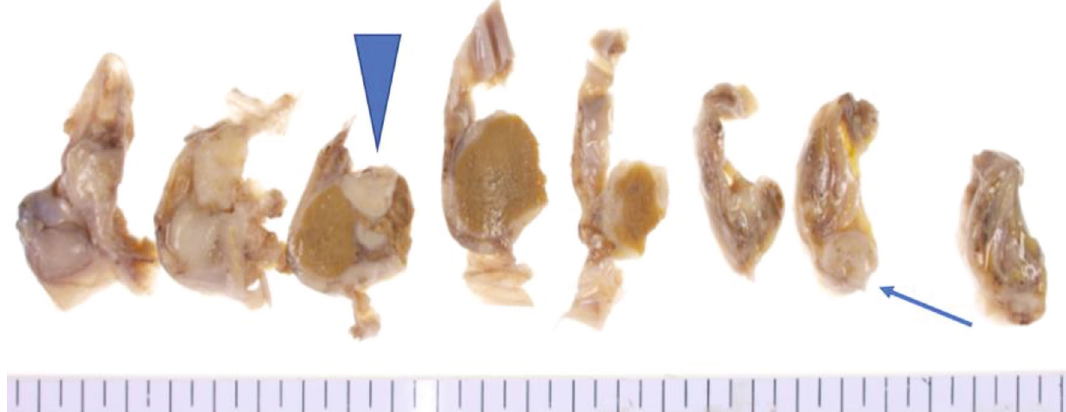
Figure 3: Macroscopic views of the resected specimen showing ill-de fi ned white solid mass found above the testis (arrow) and in the epididymis (arrowhead).